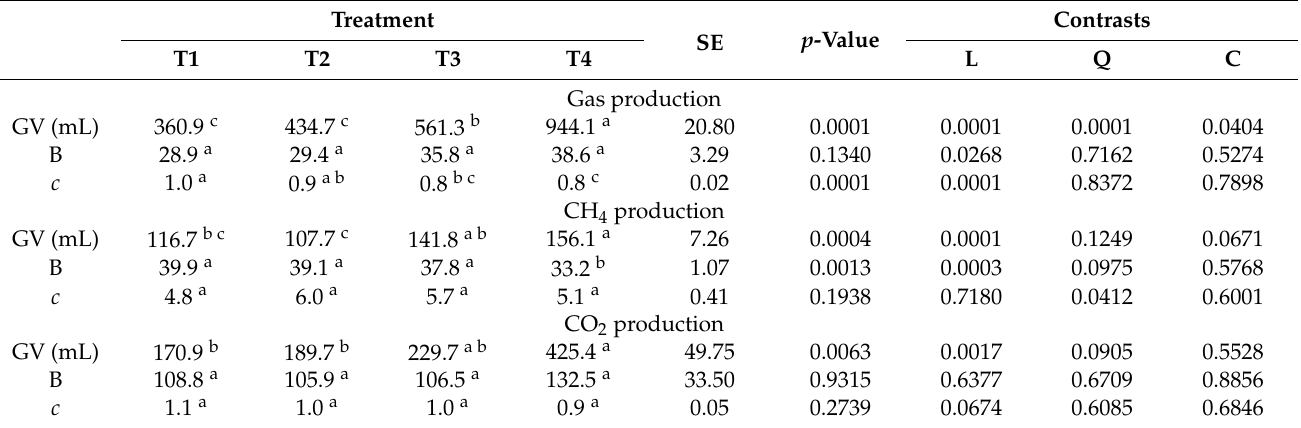
Table 4. Gas, CH 4 , and CO 2 production parameters (mL/0.500 g fermented DM) of diets with increasing levels of A